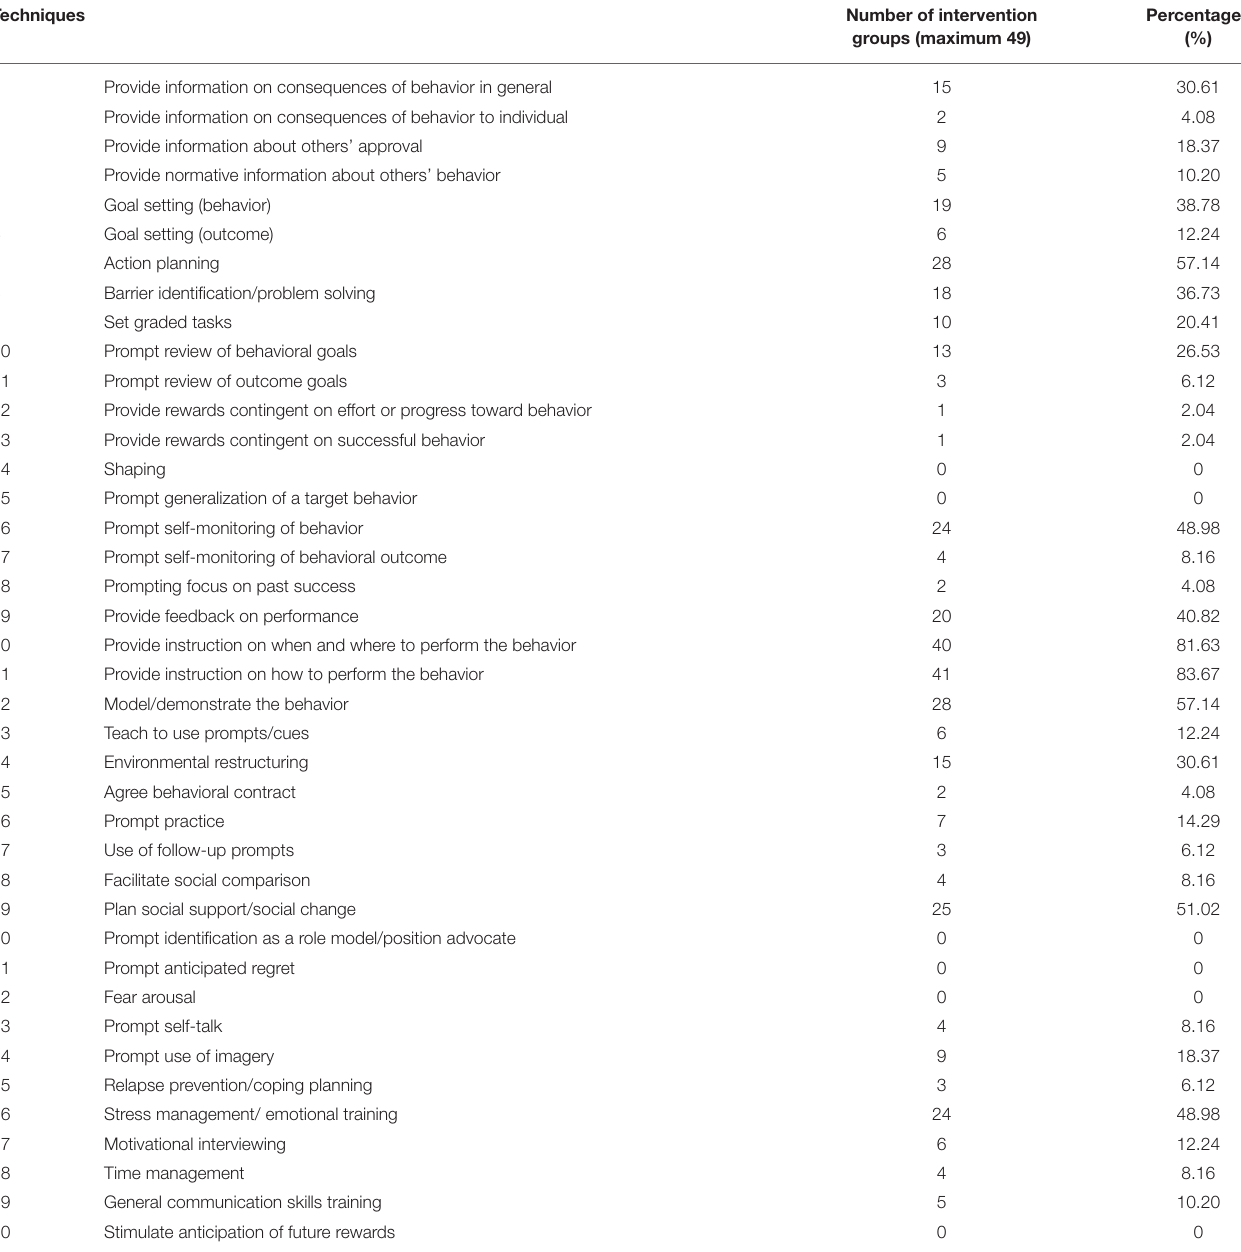
TABLE 1 | Frequencies of intervention techniques that were used in the intervention groups in meta-analytic analyses. Techniques Number of intervention